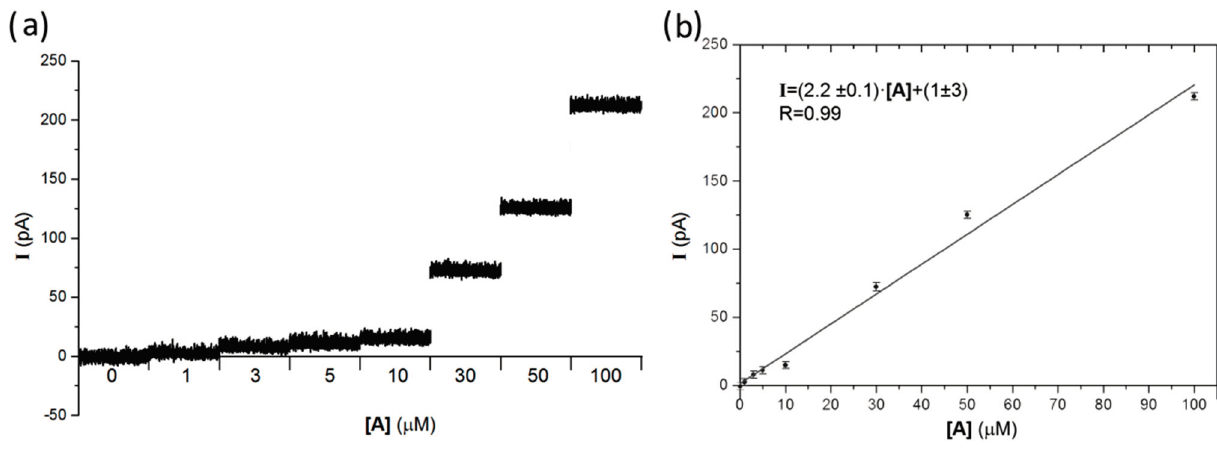
Figure 5. ( a ) Amperometric chronograms in correspondence of the reported adrenaline concentrations, polarized to +800 mV with respect to the quasi-reference electrode. For each adrenaline concentration, the acquisition lasted 60 s, while in the graph only 1 s of the recording is reported. Consecutive recordings using increasing concentrations of adrenaline were separated by time breaks, in order to properly remove the previous solution and wash the device; ( b ) average amperometric signals resulting from 60 s time averages of the data reported in Figure 5a as a function of adrenaline concentration; experimental data and relevant standard error values are shown respectively in circular dots and error bars, while the linear fit is reported in continuous